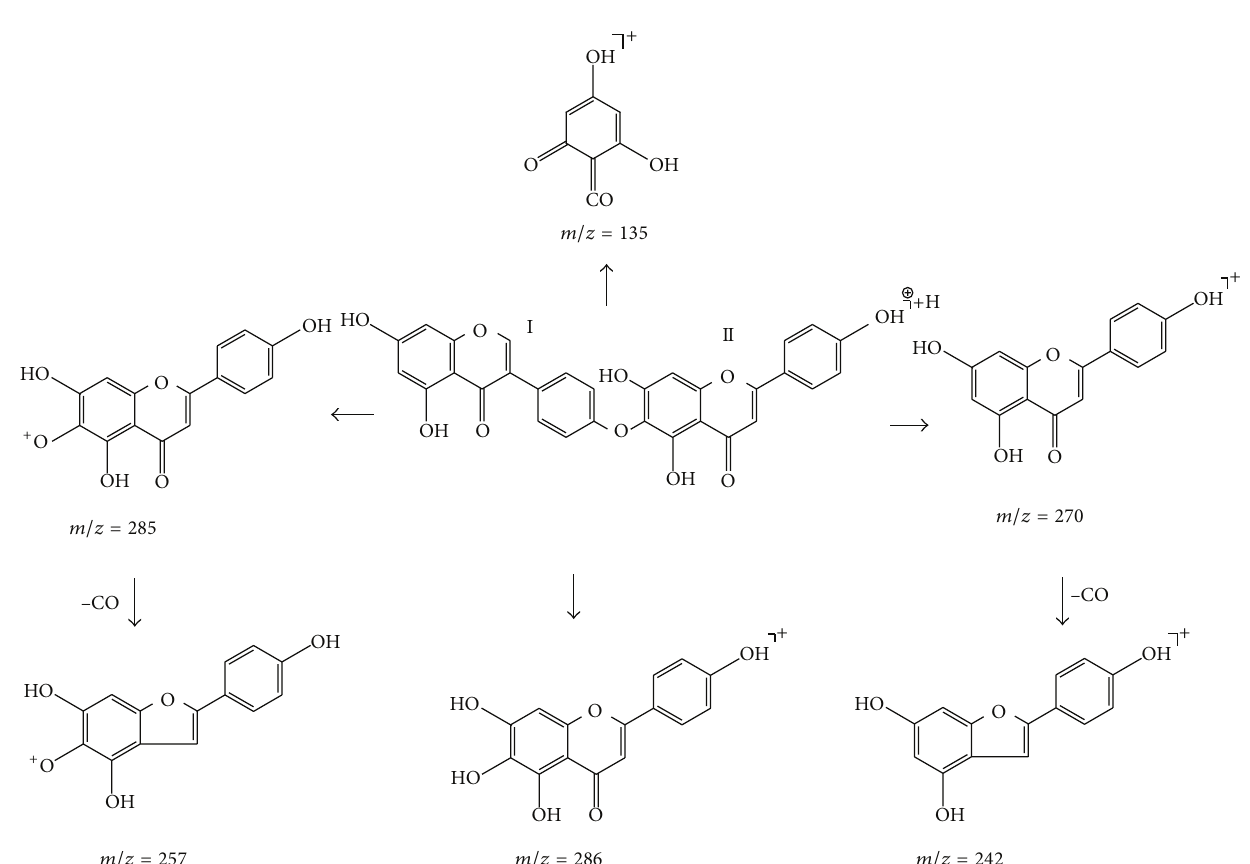
Figure 5: Proposed fragmentation pathways of